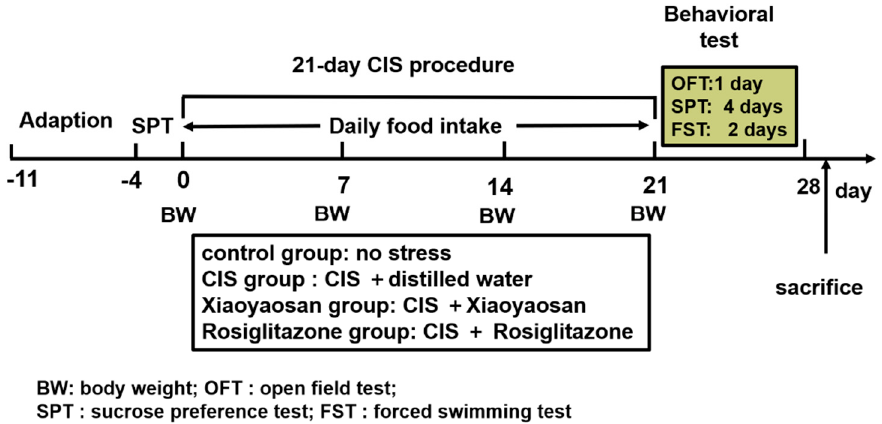
Figure 7. Experimental schedule of this study. After one week of adaption, a sucrose preference test (SPT) was conducted as a baseline to determine the initial behavioural state of the rats. During the 21-day CIS procedure, rats in each group received the respective treatment. The open field test (OFT), SPT and forced swimming test (FST) were conducted to detect depression-like behaviour in rats after CIS stimulation. Animals were sacrificed, and tissue was collected at the end of behavioural testing.